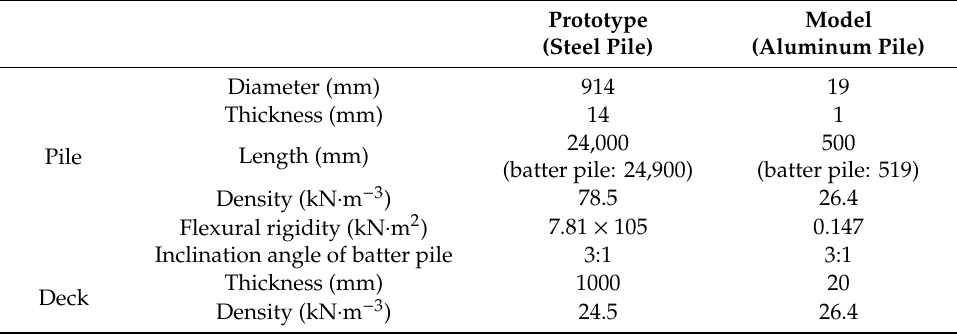
Table 2. Prototype and model properties (scale factor = 48).